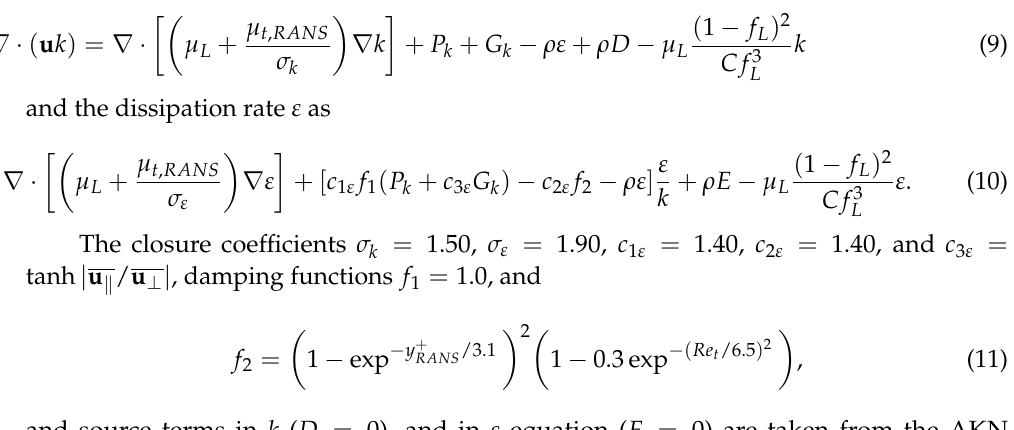
and source terms in k ( D = 0), and in ε equation ( E = 0) are taken from the AKN model [18]. The u represents the mean value of velocity with (cid:107) representing parallel and ⊥ perpendicular velocity components. The dimensionless distance to the walls is defined as